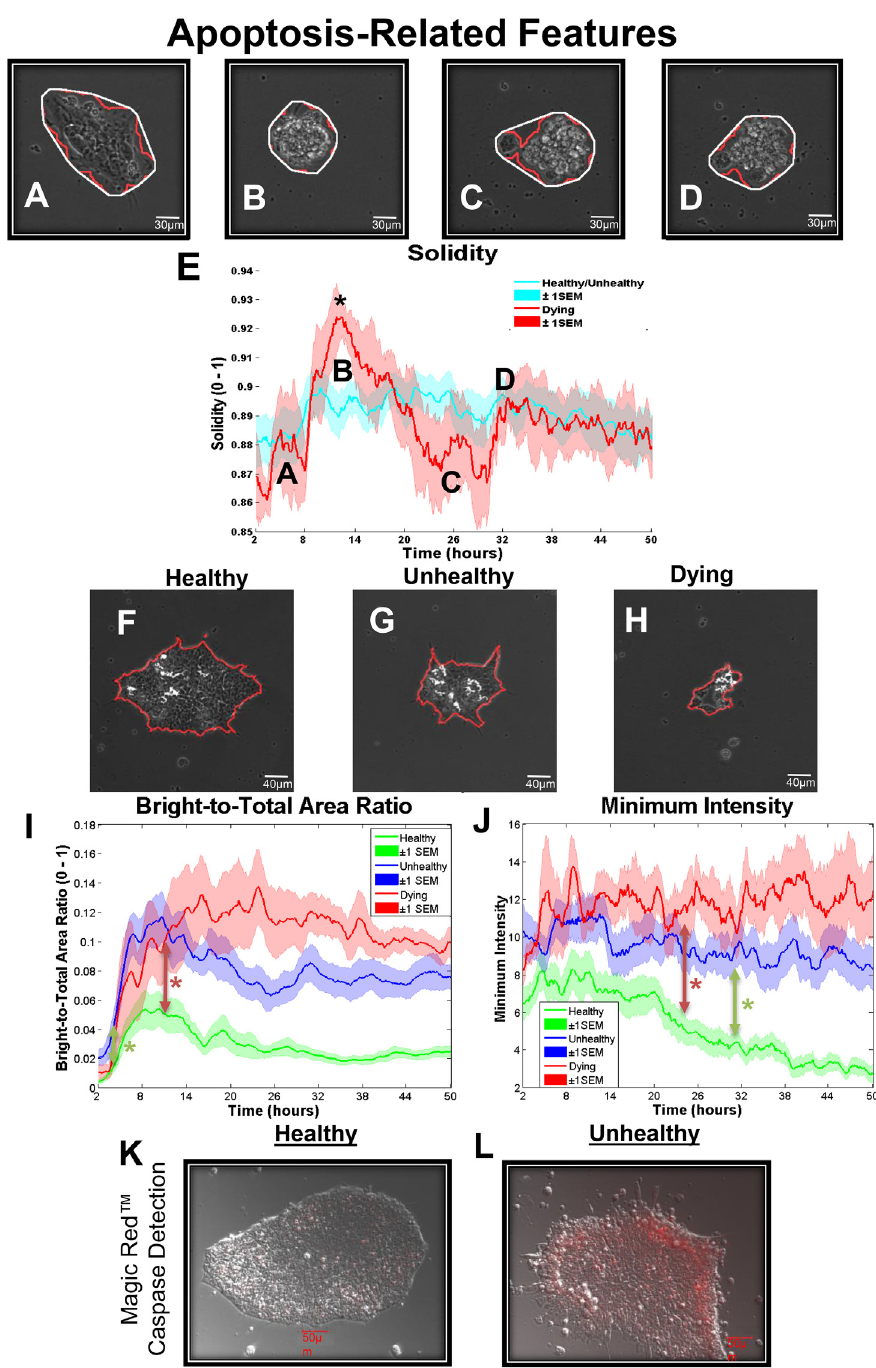
Fig 4. Features related to cell death. (A-D) Frames representing the beginning of the video (A), the highest and lowest solidity values respectively (B and C), and the time of death of dying colonies (D). E) Solidity values over time for healthy/unhealthy (blue) versus dying colonies (red). Colonies that eventually died are distinguished by a large peak in solidity between 8 – 24 hours. A one-tailed independent sample t-test at 12 hours revealed that the two groups were significantly different (P = 0.0285). (F-H) White regions on top of hESC colonies (outlined in red) represent dead cells, shown at the end of recording for a healthy colony (F), unhealthy colony (G), and dying colony (H). (I) Bright-to-total area ratio over time for healthy, unhealthy, and dying colonies. Colonies first became significantly different by 2-way ANOVA at 4 hours for healthy versus unhealthy groups (green arrow), and at 11.5 hour for the healthy versus dying groups (red arrow).